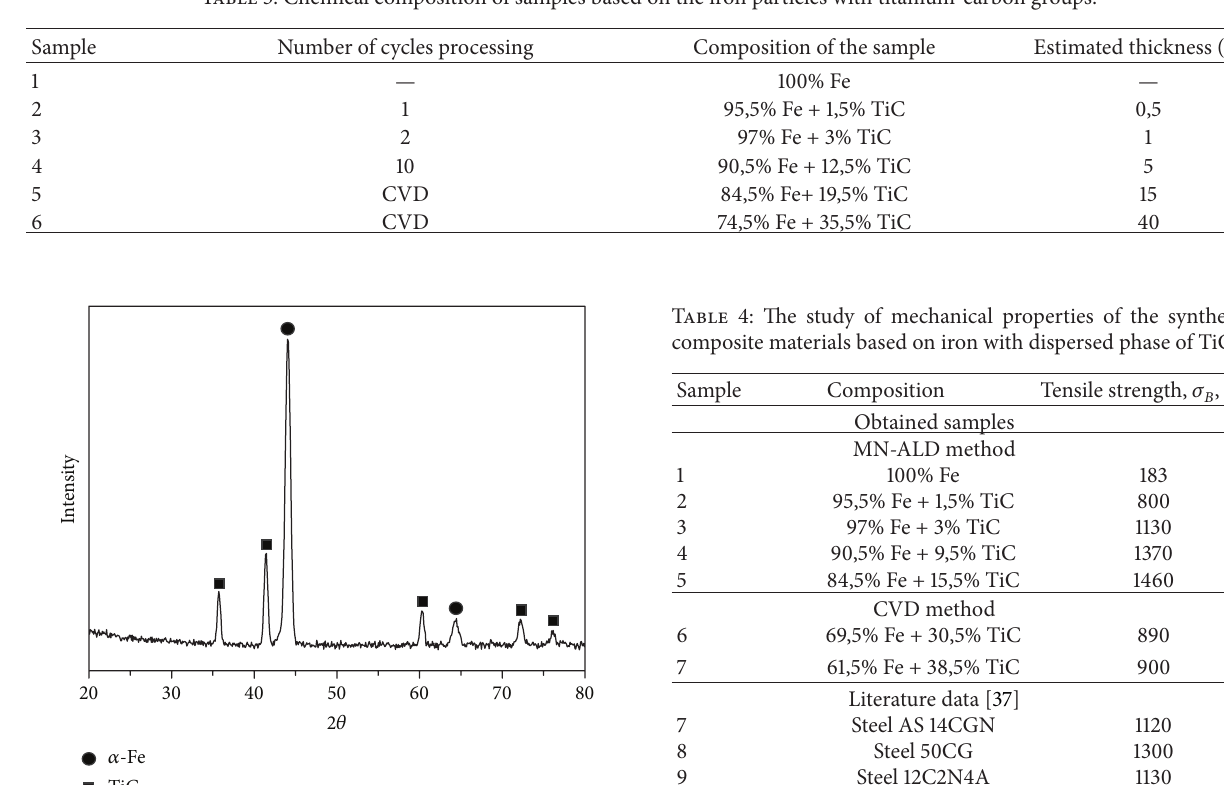
Table 3: Chemical composition of samples based on the iron particles with titanium-carbon groups.